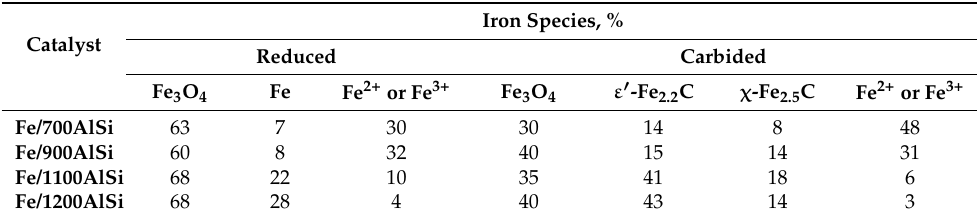
Figure 7. The change in distribution of the iron phases as the function of support pretreatment temperature. Table 6. Phase identification of iron from Mossbauer spectroscopy analysis at 20 K for reduced or carbided catalysts with support calcination at different temperatures.